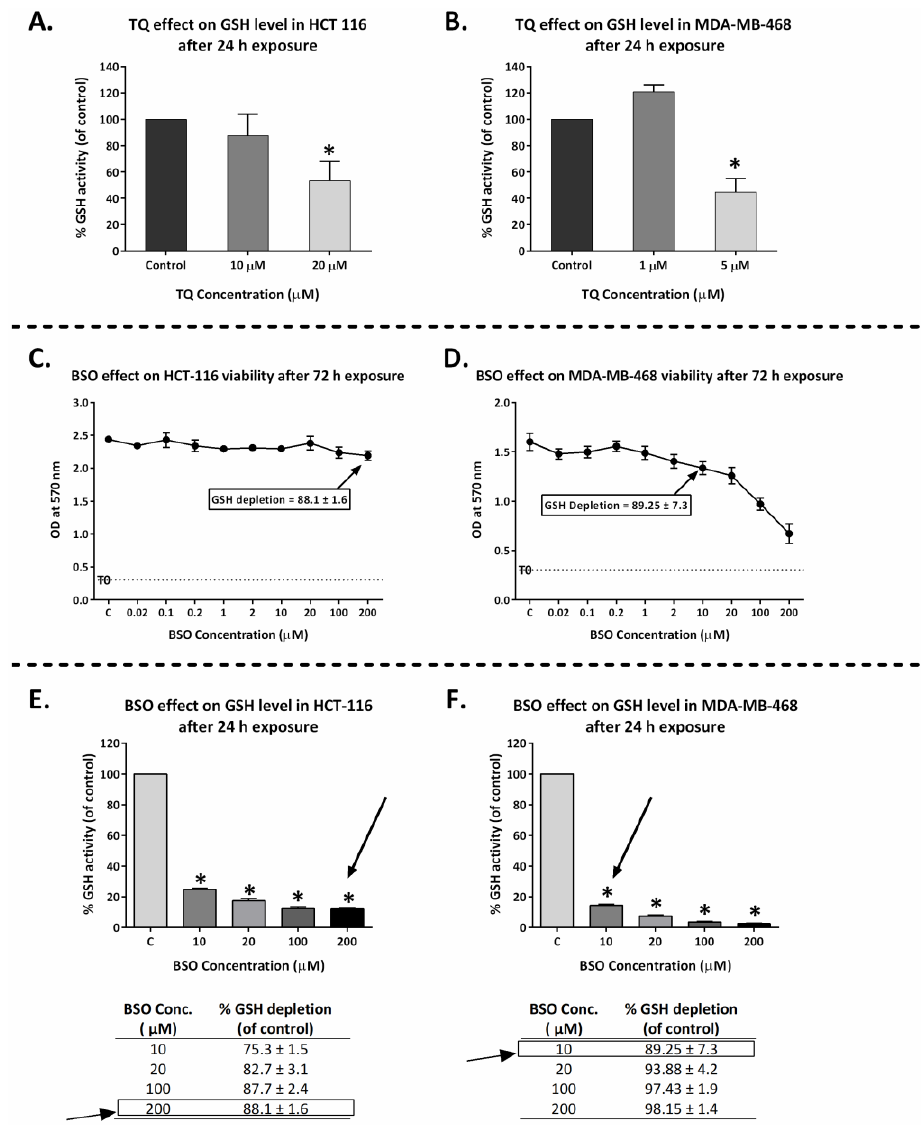
Figure 9. GSH depletion study in MDA-MB-468 and HCT-116 cells. ( A , B ): Mean ± SD bars showing GSH activity level in MDA-MB-468 and HCT-116 after 24 h TQ treatment using 1, 5 µ M and 10, 20 µ M, respectively. TQ significantly depleted GSH in MDA-MB-468 and HCT-116 at 5 µ M and 20 µ M, respectively. ( C , D ): Line graphs showing growth-inhibitory effects of BSO in MDA-MB-468 and HCT-116. Means ± SDs from one representative MTT trial (No. trials ≥ 3; n = 4 per independent experiment). Cells were seeded in 96-well plates (3 × 10 3 cells/well) and treated with BSO for 72 h. ( E , F ): Mean ± SD bars shows GSH depletion by BSO in MDA-MB-468 and HCT-116 cells following 24 h exposure. Rectangles show the optimum BSO concentrations for GSH depletion with minimal effects on cell proliferation. Asterisk indicates a statistically significant ( p ≤